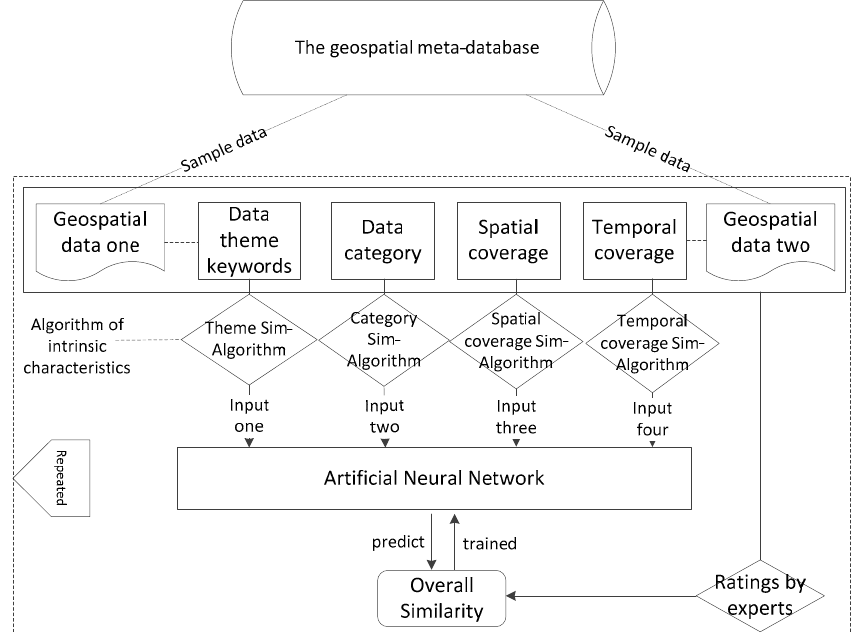
Figure 1. The basic ideal of our approach.